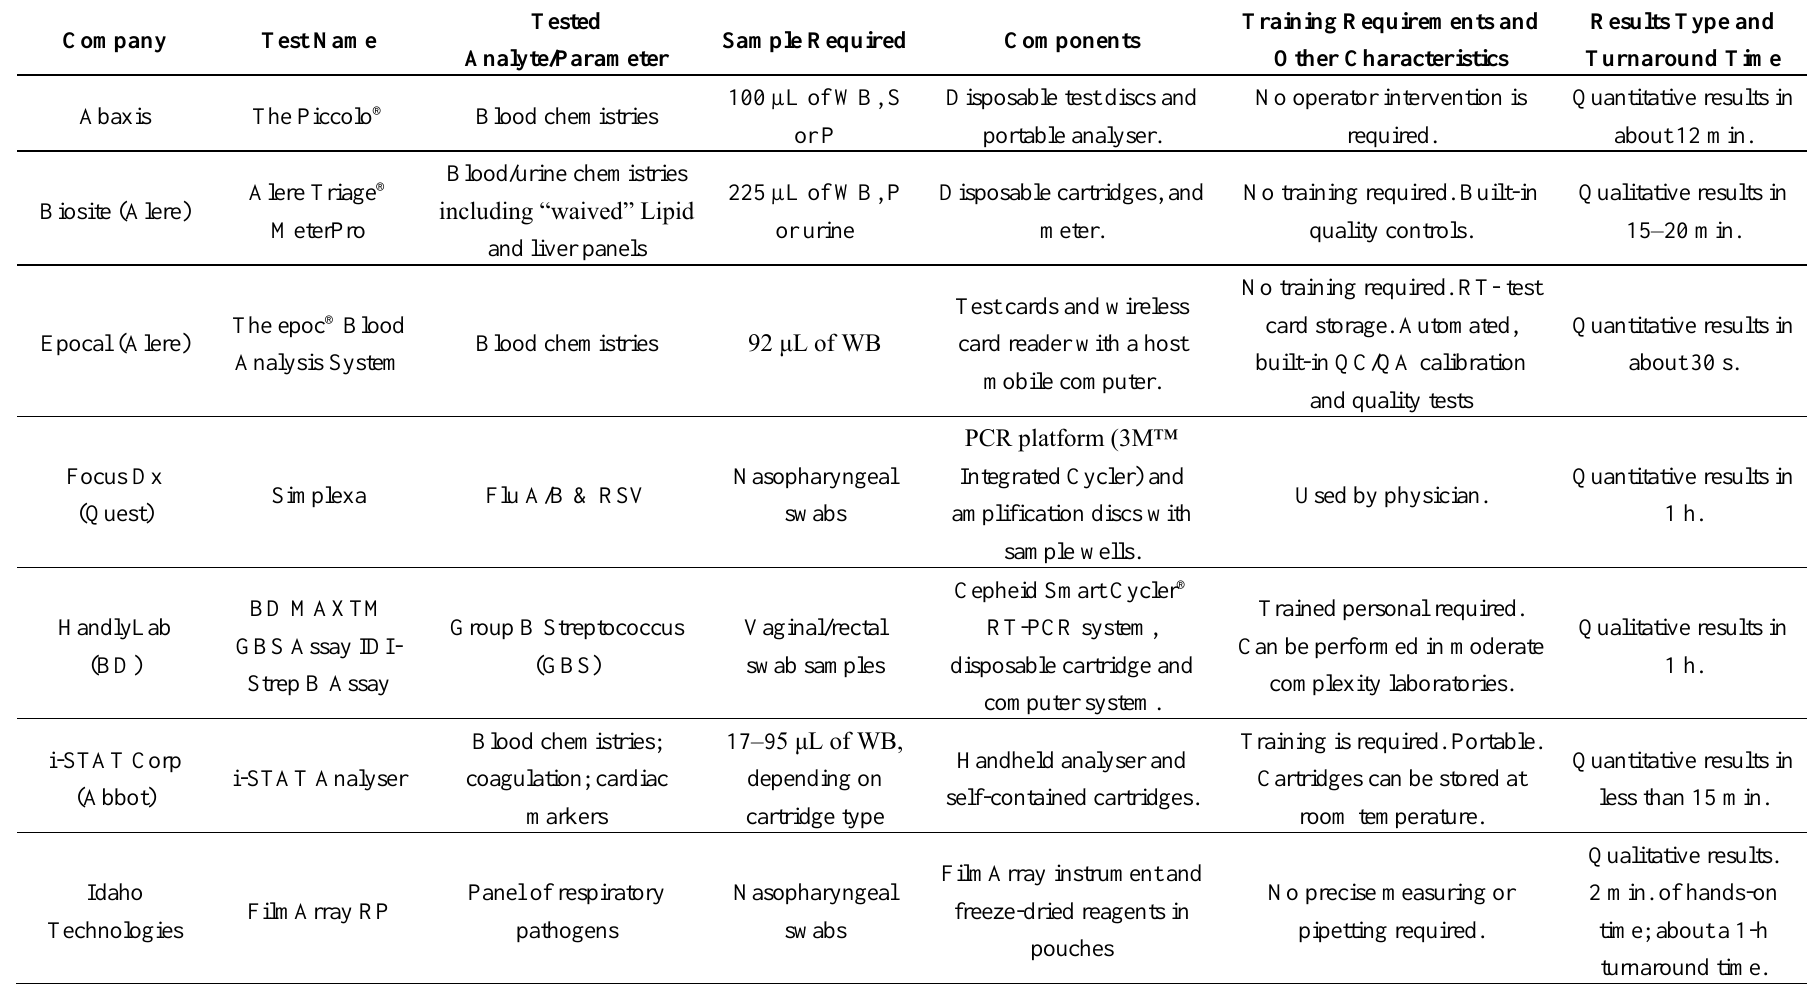
Table 2. List of FDA-approved microfluidic-based POC tests. Adapted from Chin et al.